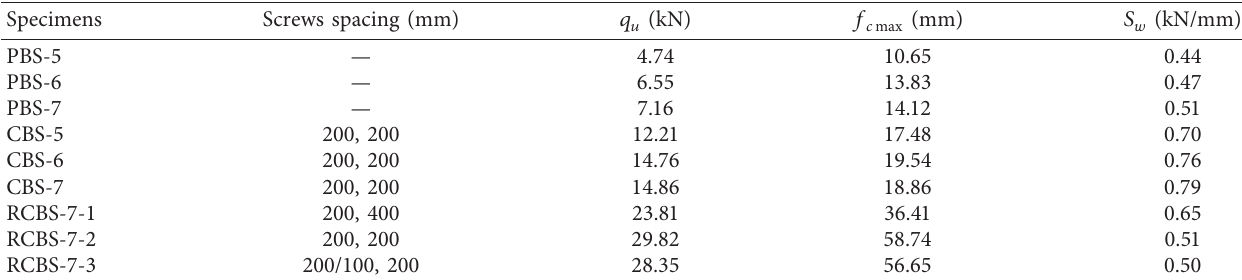
Figure 9: Load-deflection curves for bamboo-steel composite slabs. (a) Load-deflection curves for PBS. (b) Load-deflection curves for CBS. (c) Load-deflection curves for Table 3: Test results of large-scale specimens.